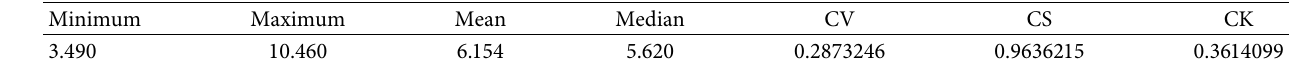
Figure 4: Fitted CDFs for annual maximum temperature dataset. Table 9: Descriptive statistics of Ghana unemployment rate